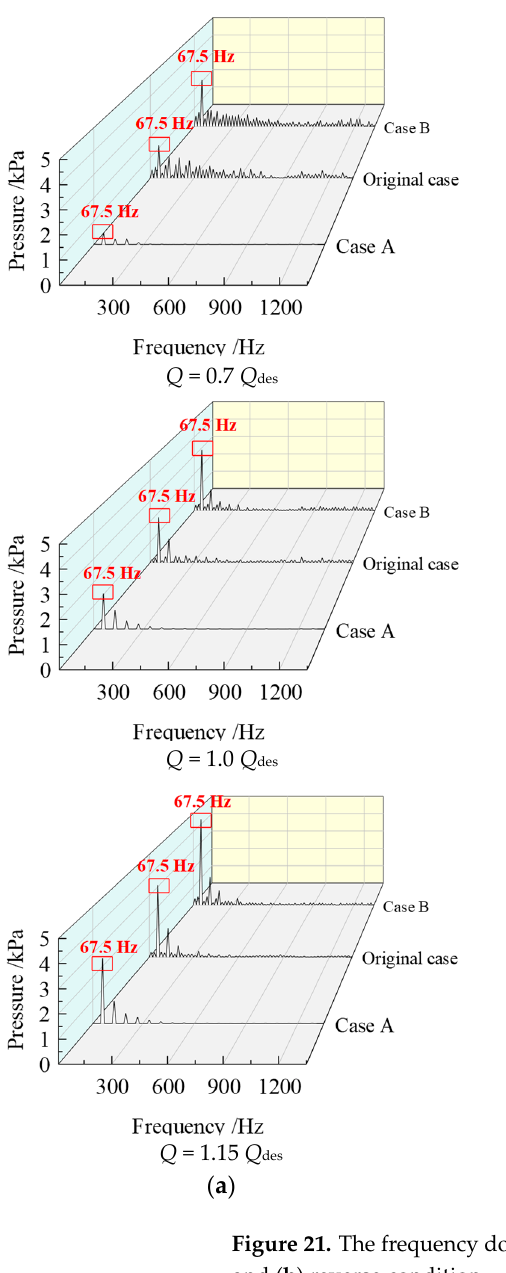
Figure 20. The frequency domain of pressure signal on A1 of three cases under ( a ) forward and ( b ) reverse conditions.